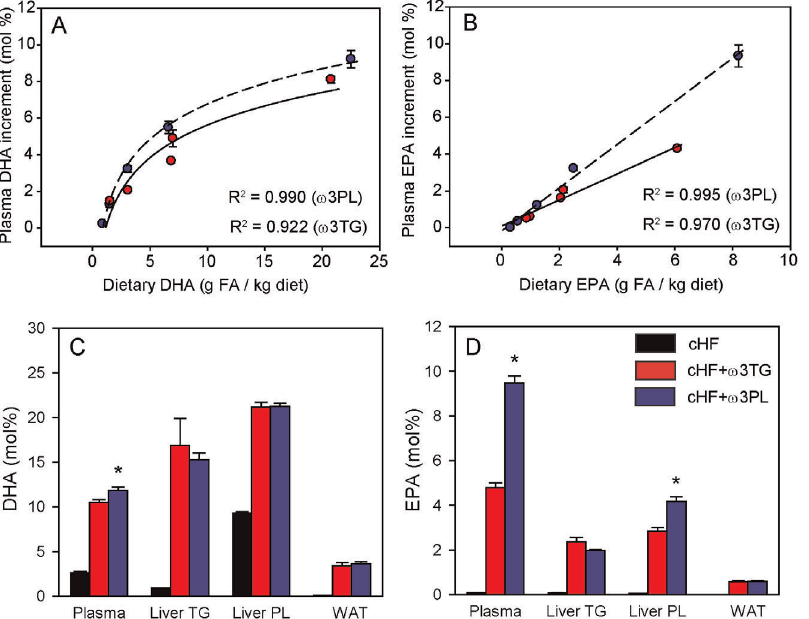
Figure 2. Bioavailability of DHA and EPA and their accumulation in the liver and WAT in the ‘prevention study’. A , B Fatty acid ( FA ) composition of total lipids in plasma was analyzed in mice fed for 2 weeks with the cHF + v 3TG (red circles) or cHF + v 3PL (blue circles) diet with various concentrations of DHA/EPA. The correlation plots between dietary content and the corresponding increments in plasma concentrations of DHA ( A ) and EPA ( B ) corrected for the values in the cHF-fed mice (DHA, 2.49–2.84 mol %; EPA, 0.05–0.16 mol %; see also Fig. 2C,D). The coefficient of determination (R 2 ), describing the proportion of the dependent variable that is explained by the independent variable, is also shown. The concentration of DHA ( C ) and EPA ( D ) in total plasma lipids, liver triglycerides ( TG ) and phospholipid ( PL ) fraction, and in total lipids from epididymal white adipose tissue ( WAT ) was assessed in mice from the ‘prevention study’ following 9 weeks of feeding cHF + v 3TG (red bars) and cHF + v 3PL (blue bars) diets supplemented with 30 g DHA/EPA per kg, or the control cHF diet (black bars). For the detailed data on fatty acid composition, see Tables S4, S5, S6, S7). Data are means 6 SEM ( n =4 2 7); if SEM is not shown, it is smaller than the symbol size ( A,B ). *Significantly different from cHF + v 3TG